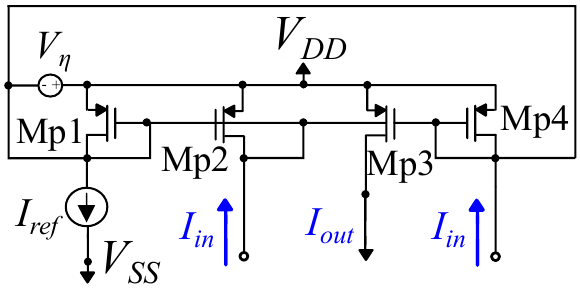
Figure 9. An example transistor level implementation of a basic squarer block.